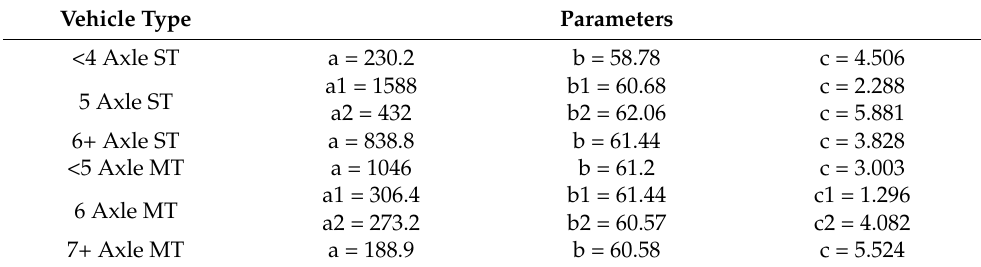
Table 3. Vehicle speed fitting parameters for each vehicle type.